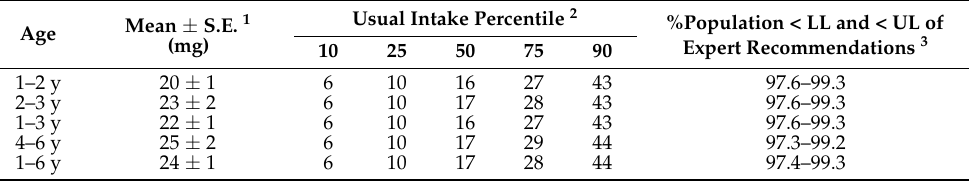
Table 6. Percentage of children 1–6 years with nutrient biomarkers below deficiency levels (NHANES 2001–2016). Cut Off Value for Serum Biomarker